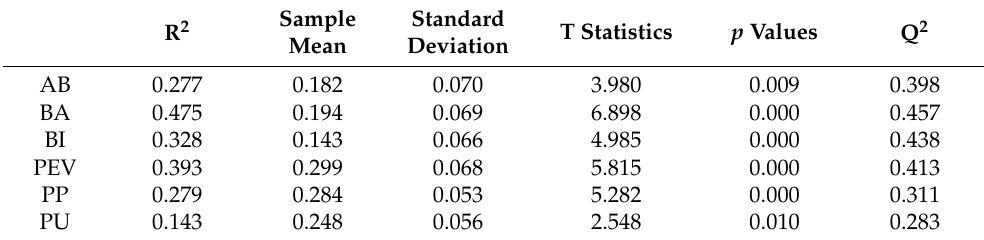
Table 8. Structural model